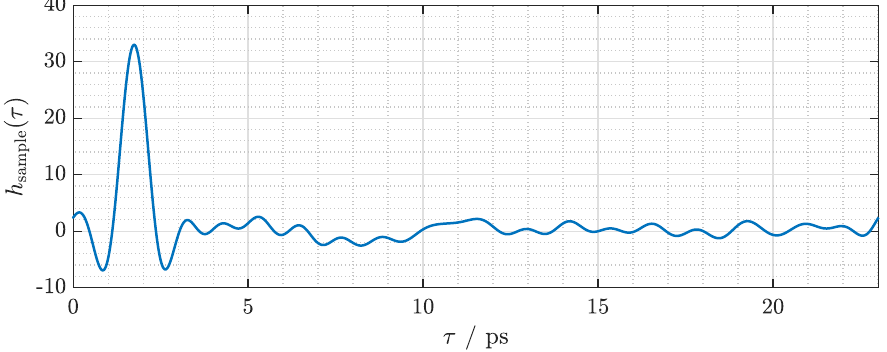
Figure 10. Impulse response of the COC